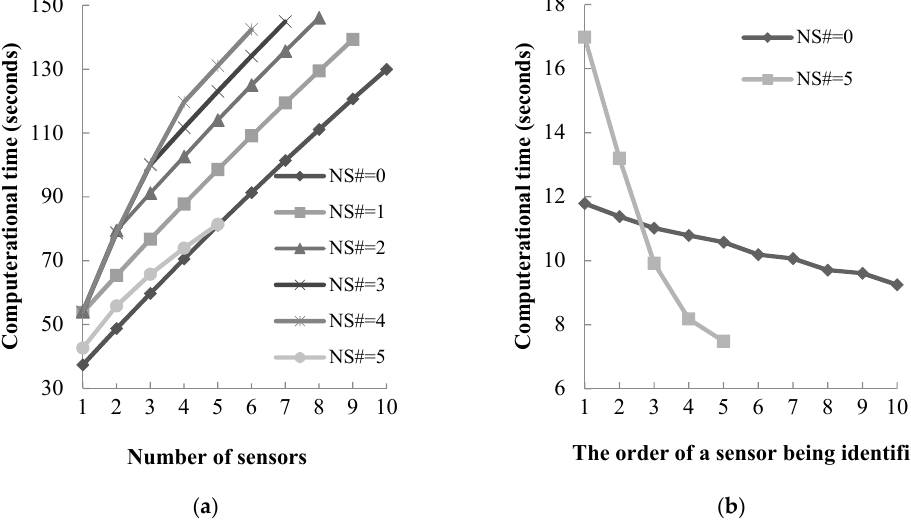
Figure 3. Computational time using the proposed algorithm: ( a ) cumulative computational time for each given number of node sensors; and ( b ) computational time for identifying each sensor.